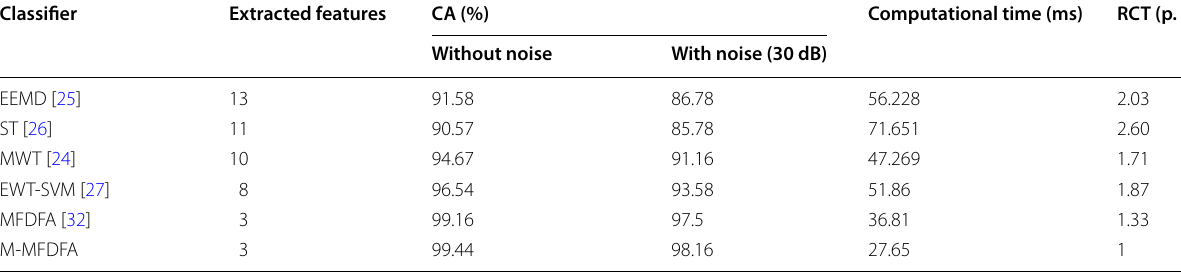
Table 8 Comparison between the proposed classifier and the existing classifiers